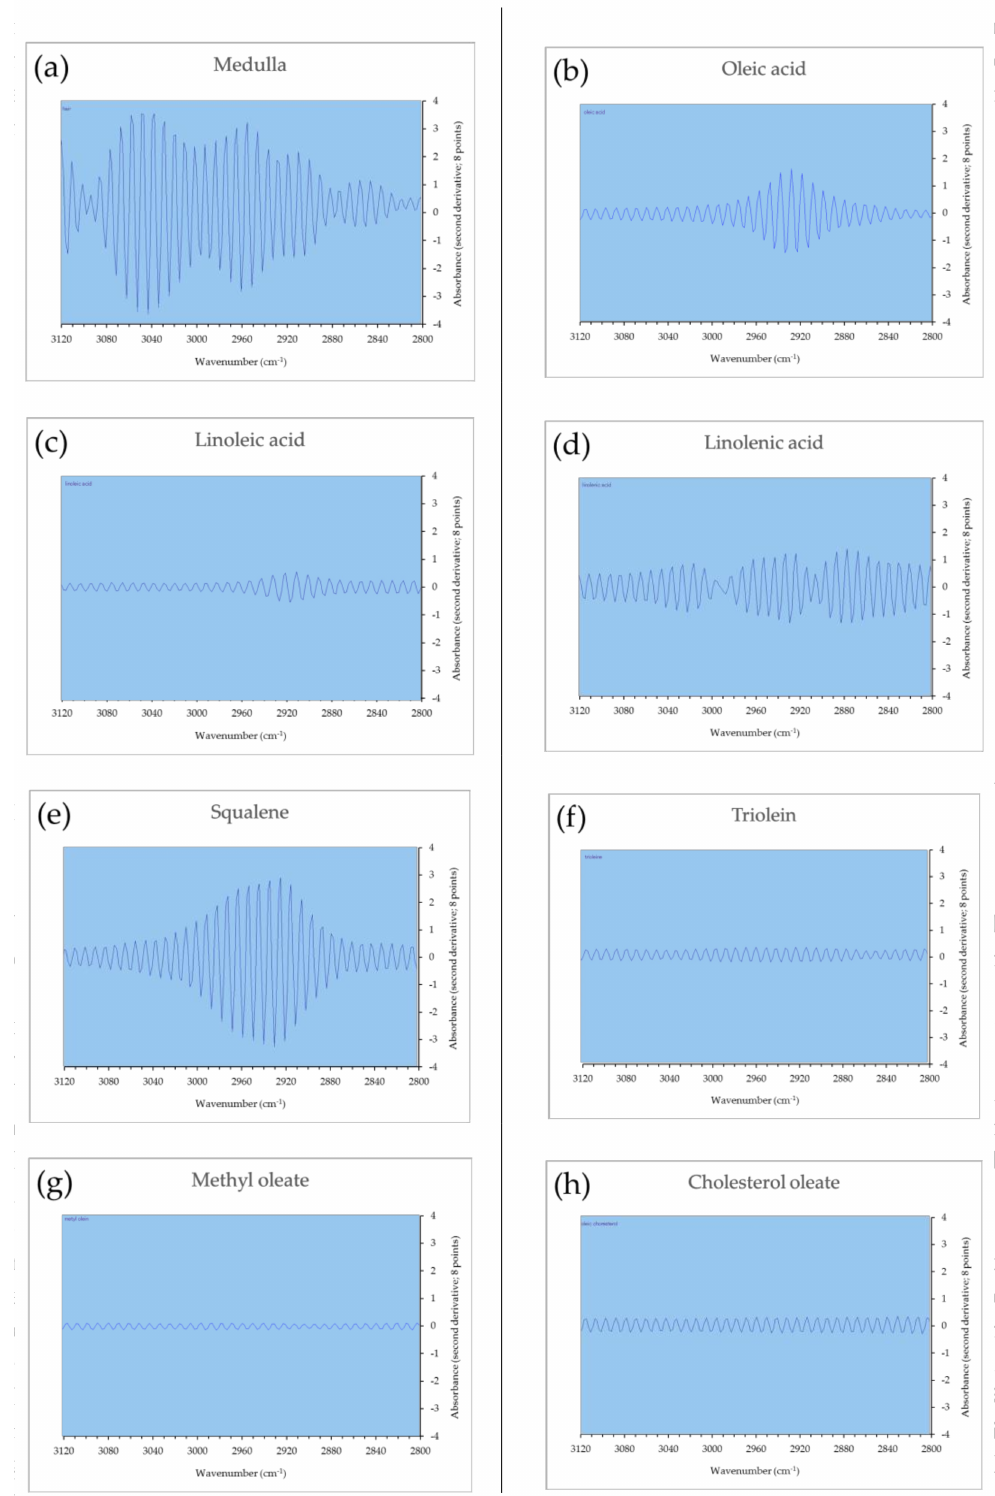
Figure 7. Second derivative micro-attenuated total reflectance Fourier-transform infrared spectrophotometry (micro-ATR FTIR) spectra of the medulla and lipids. ( a ) Medulla, ( b ) oleic acid, ( c ) linoleic acid, ( d ) α -linolenic acid, ( e ) squalene, ( f ) triolein, ( g ) methyl oleate, and ( h ) cholesterol